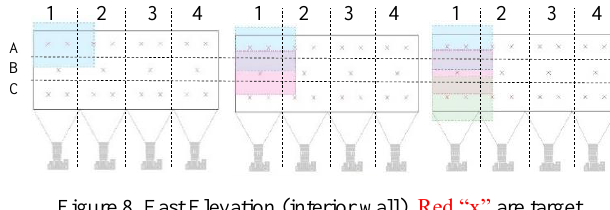
Figure 8. East Elevation (interior wall). Red “x” are target points. Left: blue square shows the first shot (notice how it overlaps 1/3 rd of the grid below and the grid on the right of the shot). Center: Pink square is the Second shot. Right : Green square is the third shot. (Drawn by Rajabzadeh, 2021)